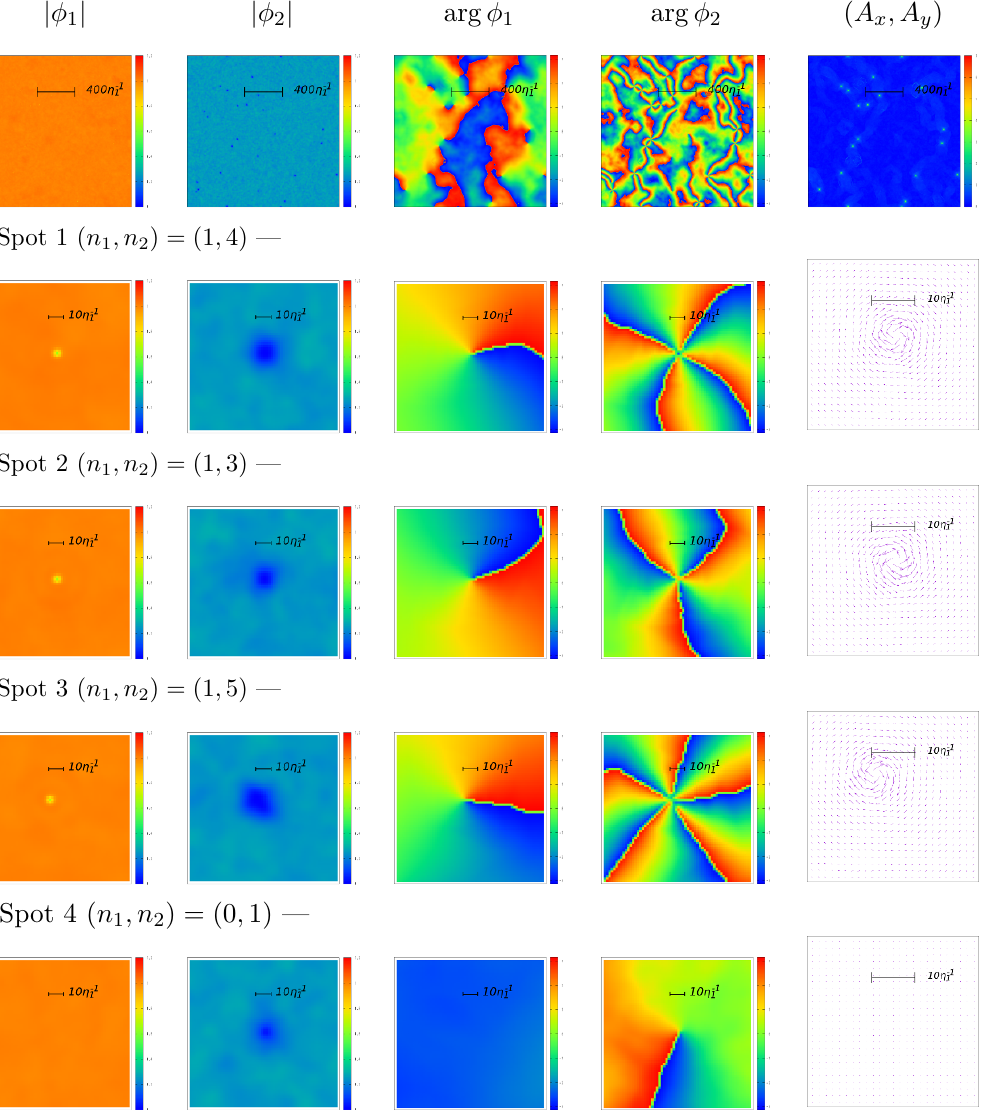
Figure 4. The (cid:12)eld con(cid:12)gurations in 2-dimensional space after the phase transition. The (cid:12)rst row shows the (cid:12)eld con(cid:12)guration in the whole two-dimensional simulation box. The following rows are the closeups of the example spots with string con(cid:12)gurations. The right panels show the amplitude of the gauge (cid:12)eld in the whole simulation box (Top), and the gauge (cid:12)eld in the 2-dimensional space at each spot, whose amplitude is proportional to the length of the vector.